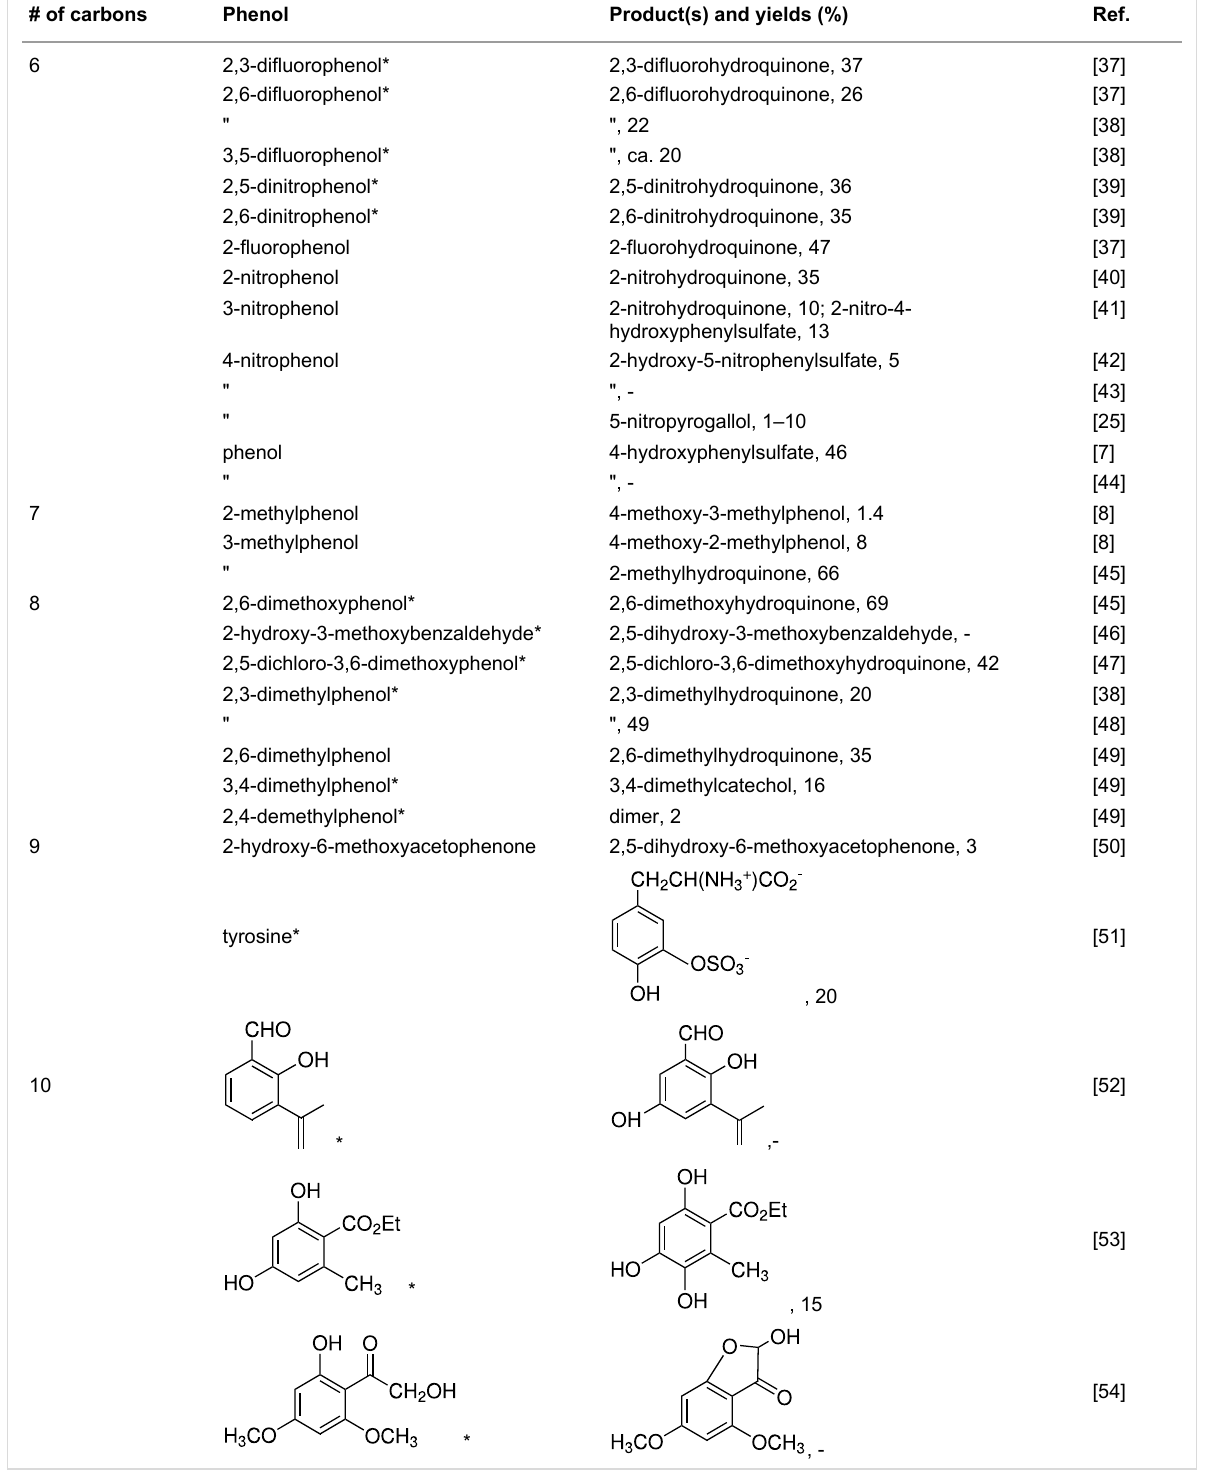
Table 1: Oxidation of phenols # of carbons Phenol Product(s) and yields (%)